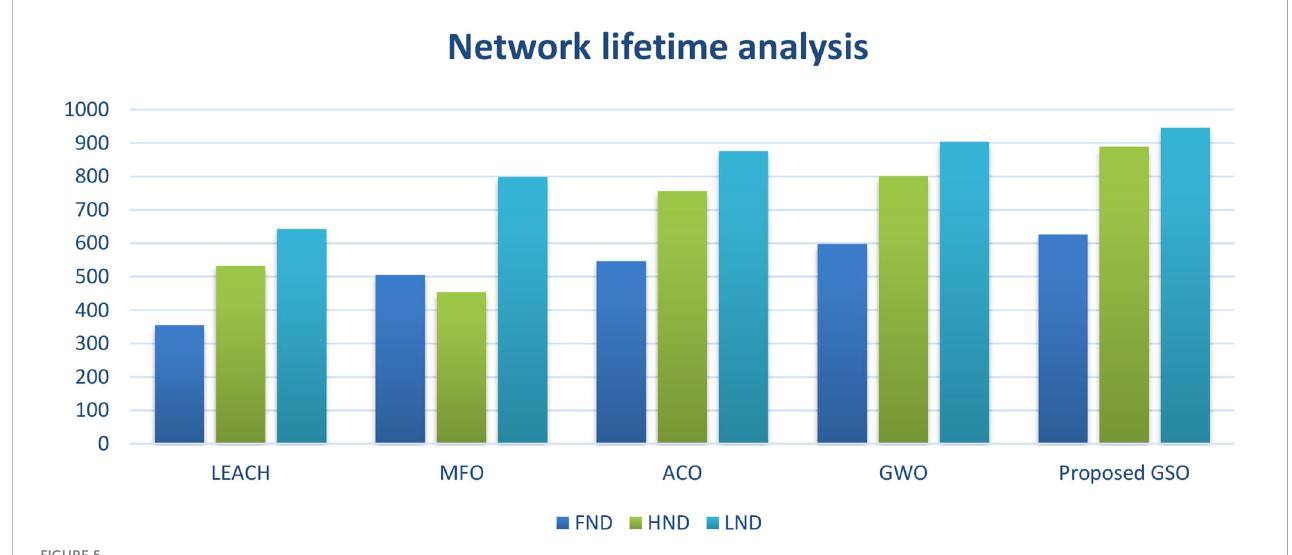
FIGURE 5 Network lifeline analysis.